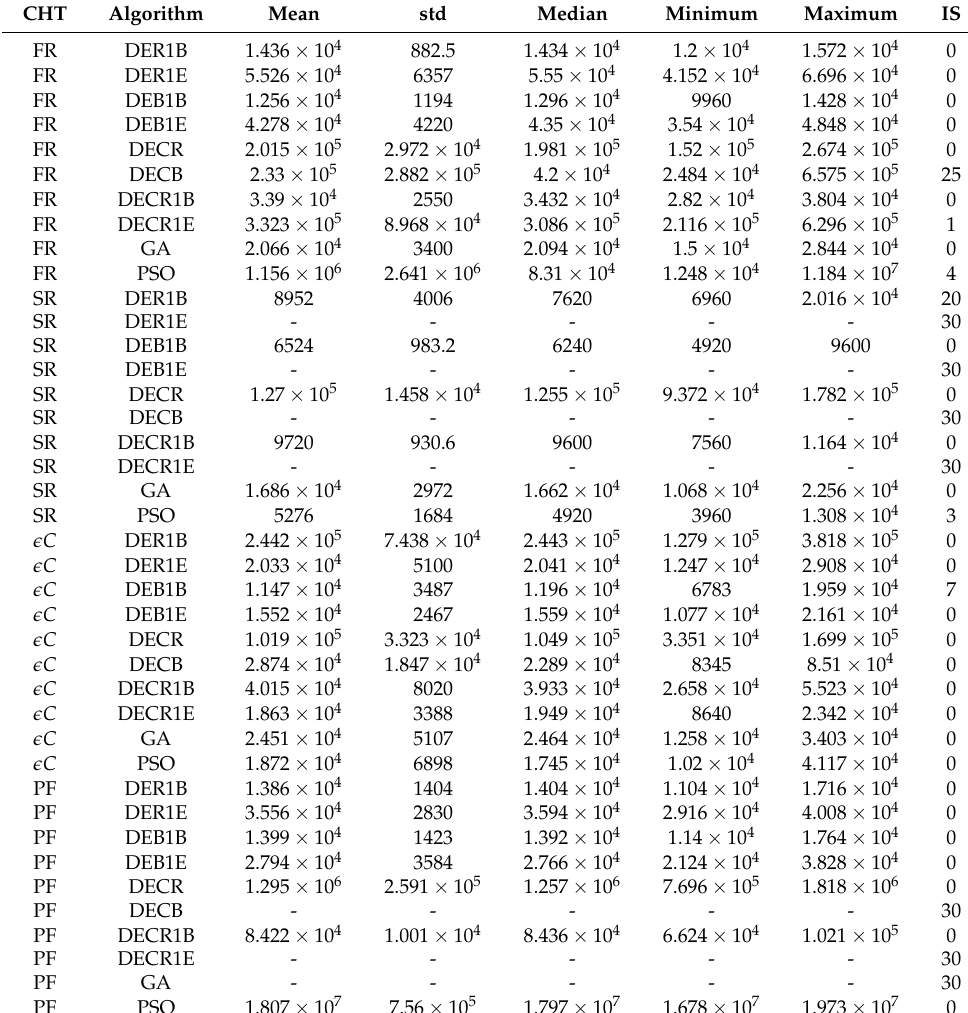
Table A18. EVALS descriptive statistics for the study case 3: Eight-bar linkage mechanism. IS means the number of infeasible solutions through the executions. “-” indicates that it is not possible to compute such a